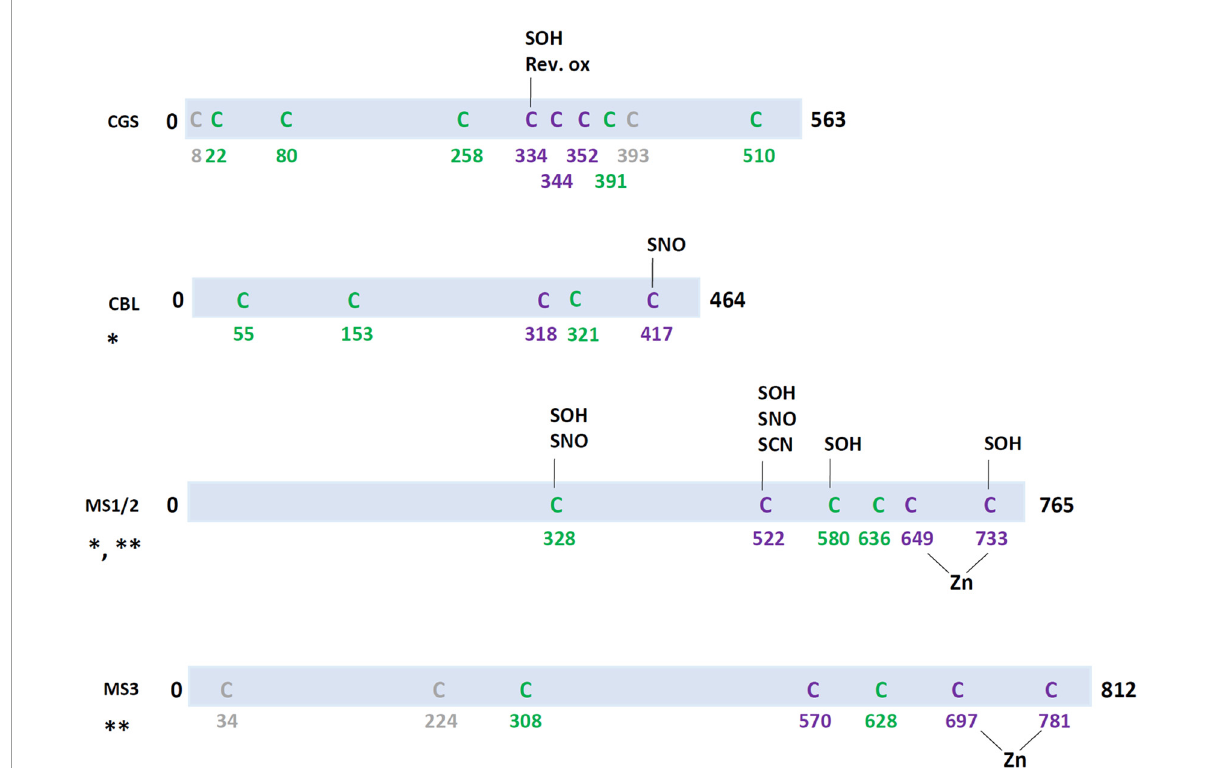
FIGURE4 Redox post-translational modifications of enzymes involved in methionine biosynthesis pathway in the green lineage. In purple, cysteines conserved in all Arabidopsis isoforms and in at least one isoform from Chlamydomonas reinhardtii (green alga), Physcomitrella patens (Bryophyte), Selaginella moellendorffii (Lycophyte), Oryza sativa (Monocot), Zea mays (Monocot), Glycine max (Annual eudicot), Brassica oleracea (Biennal eudicot), Solanum lycopersicum (Perennial), Populus trichocarpa (Perennial), and Vitis vinifera (Perennial). In green, cysteines conserved in all Arabidopsis isoforms and at least one isoform from other terrestrial plants. In gray, cysteines present in A. thaliana isoform but not conserved in isoforms from other plants. For nitrosylation (SNO), reversible cysteine oxidation (Rev. ox.), S-cyanylation (SCN) and sulfenylation (SOH), targeted cysteines are known and they are indicated on the scheme. When targeted cysteines are unknown, the following code applies: ∗ , persulfidation; ∗∗ , TRX